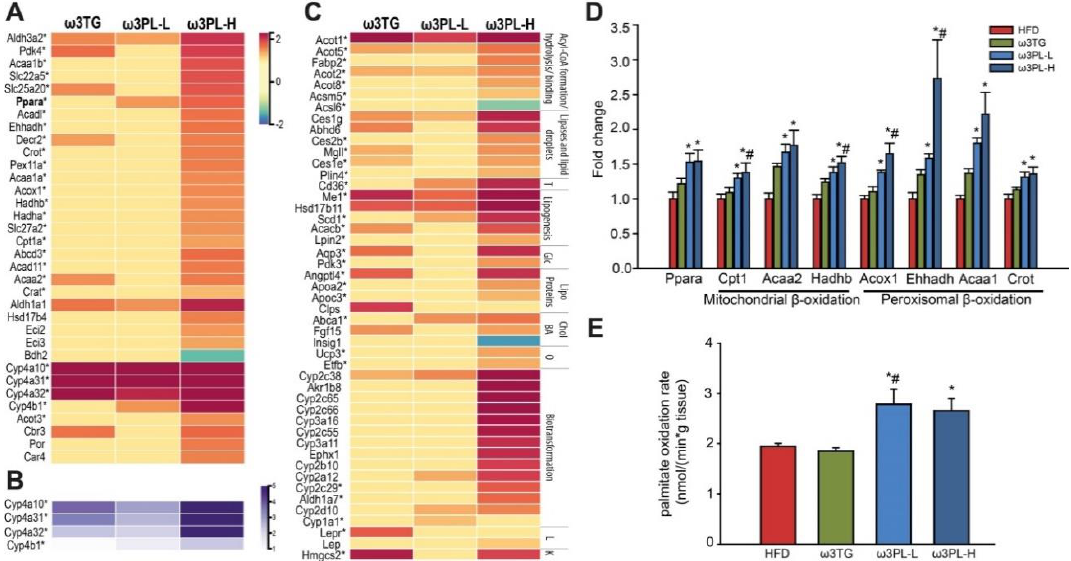
Figure 5. The effect of Omega-3 supplementation on lipid metabolism in the small intestine of dietary obese mice. ( A ) Heatmap showing the gene expression of ( A ) FA oxidation genes, ( B ) ω-oxidation genes (includes also in A - for better resolution in different color scale compared to A ) and ( C ) genes involved in different processes related to lipid metabolism (as indicated on right side) relative to HFD ( p < 0.05). T, lipid transport; Glc, glucose/glycerol transport and metabolism; Chol BA; metabolism and transport of cholesterol and bile acids; O, oxidative phosphorylation; L, leptin signaling; K, ketogenesis. ( D ) The expression of selected genes of mitochondrial and peroxisomal FA oxidation in proximal ileum. Data were expressed as relative to HFD; HFD = 1. ( E ) Quantification of FA oxidation rate in proximal ileum. Data are means ± SEM ( n = 8). *, significantly different vs. HFD; #, significantly different vs. ω3TG ( p < 0.05, one-way ANOVA). For detailed effects of HFD compared to Chow-fed mice, see Figure S2.